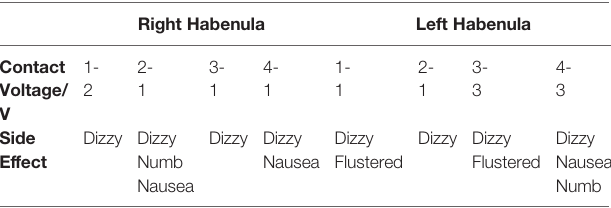
TABLE 2 | Adverse side effects of different stimulation threshold values. Right Habenula Left Habenula